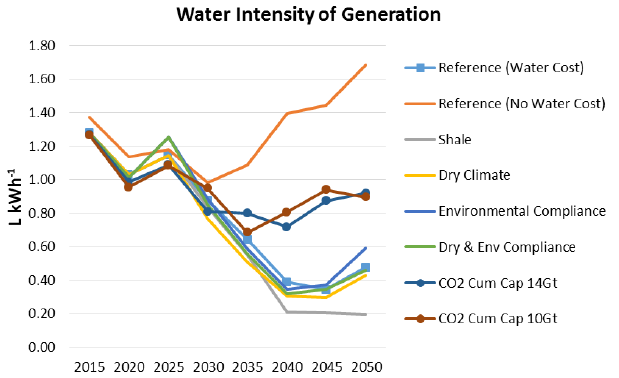
Figure 5. Resulting power sector water consumption and efficiency (lkWh − 1 ) under different model